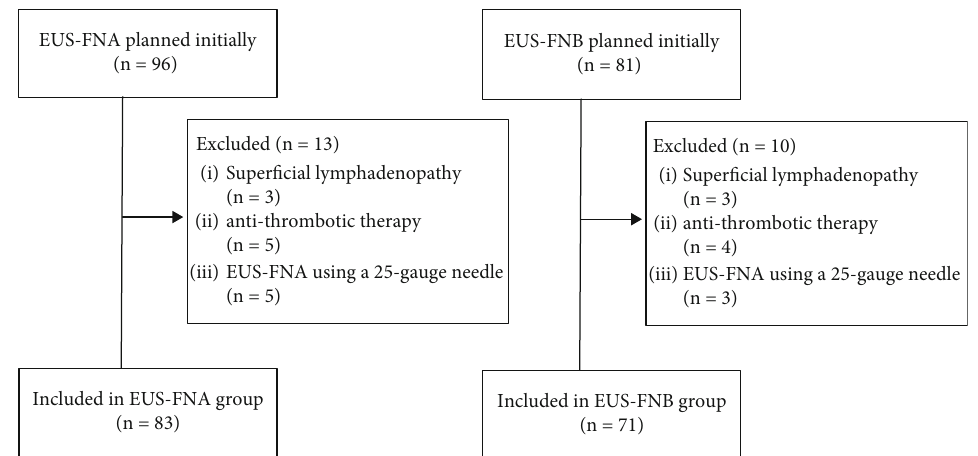
Figure 2: A fl owchart of patients ’ selection between EUS-FNA and EUS-FNB groups. Table 1: Patient characteristics between conventional (Group A) and Franseen (Group B) needle groups. Group A Group B p value